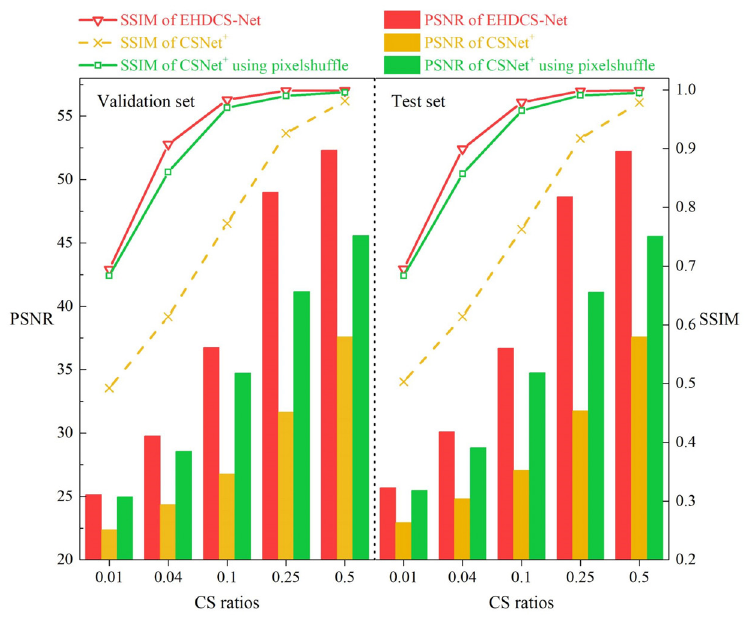
Figure 7. Comparisons of PSNR and SSIM values between CSNet+, CSNet+ using pixelshuffle, and EHDCS-Net on the validation and test sets, respectively, at different CS ratios.